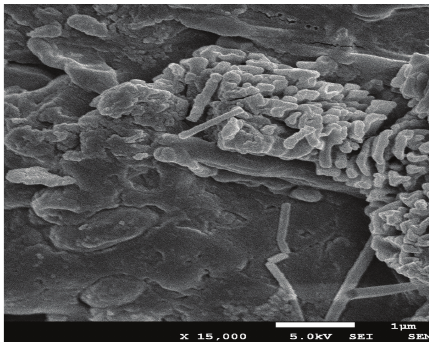
Figure 2: SEM of CaHBSD before copper adsorption.